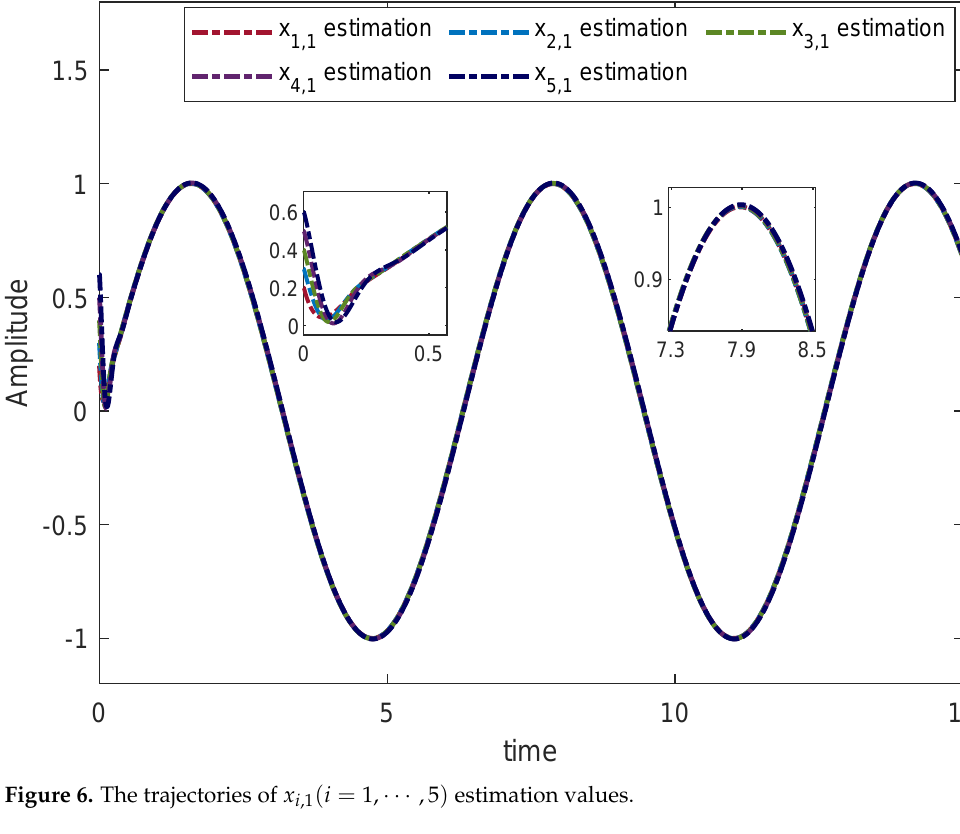
Figure 6. The trajectories of x i ,1 ( i = 1, · · · ,5 ) estimation values.